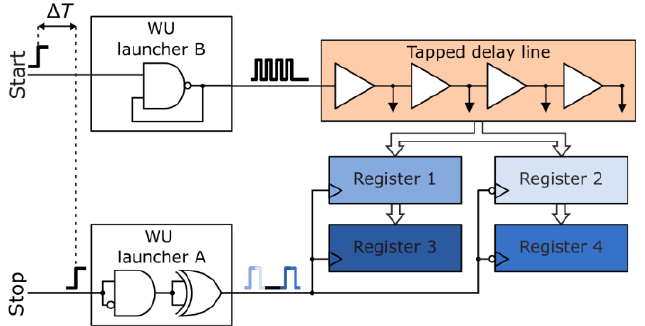
Figure 1. Multisampling wave union TDC block diagram.